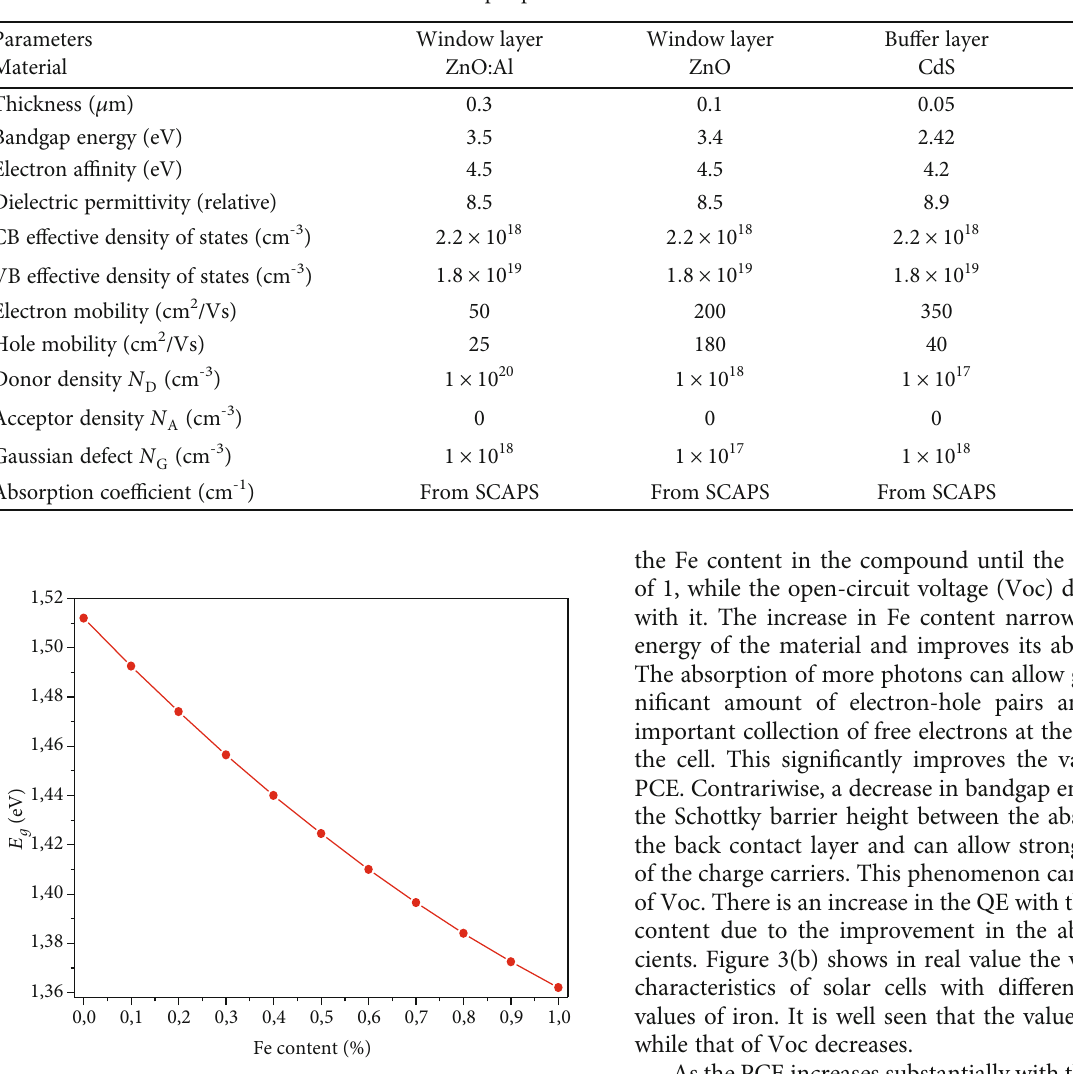
Table 1: Input parameters used in our simulations.